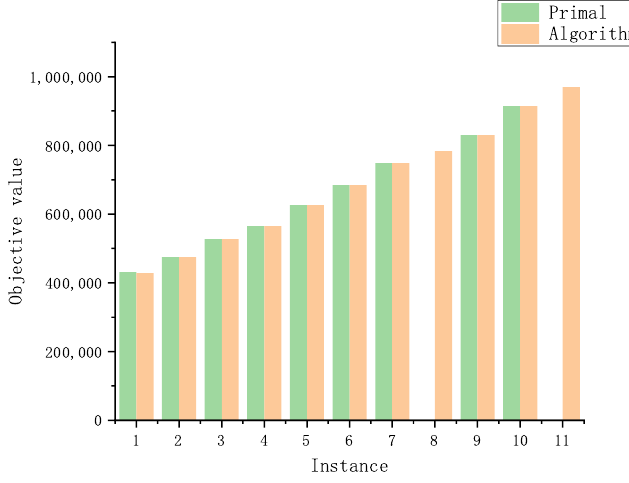
Figure 6. Objective values for large-scale instances.